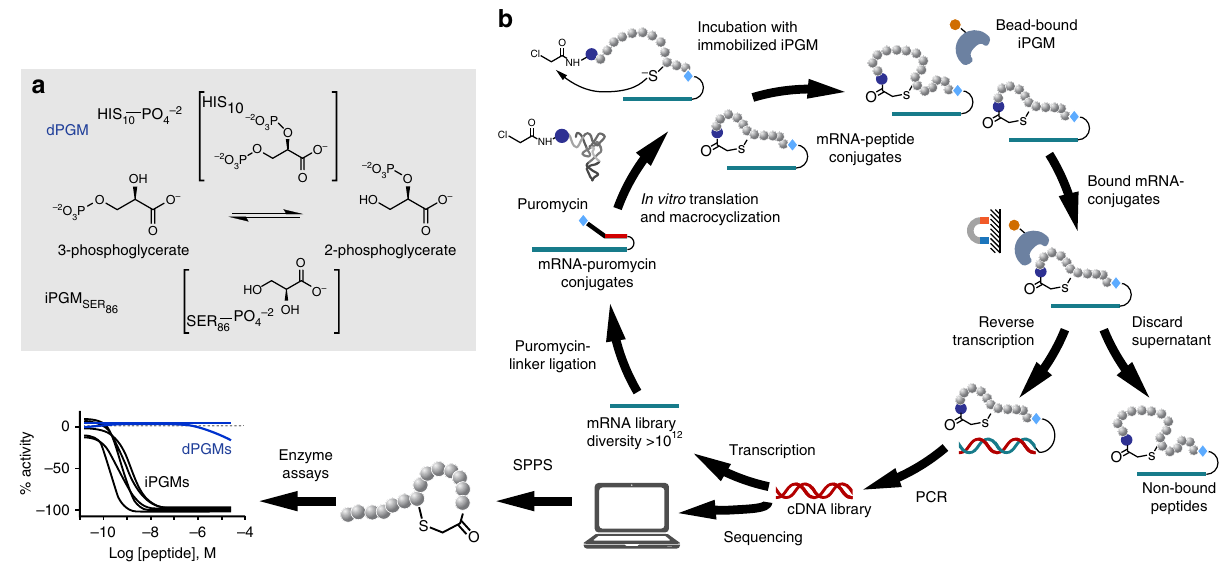
Figure 1 | Species-dependent phosphoglycerate mutase catalytic mechanisms and overview of affinity selection. ( a ) Isomerization catalysed by PGMs illustrating the phosphohistidine enzyme/2,3-phosphoglycerate intermediate of human cofactor-dependent PGM (top) and the phosphoserine enzyme intermediate of C. elegans cofactor-independent PGM. ( b ) Random nonstandard peptide integrated discovery (RaPID) begins with an mRNA library encoding trillions of potential peptides 6–14 amino acids in length. The mRNA library is ligated to an adapter incorporating the amino nucleoside, puromycin. The flexible in vitro translation (FIT) system is used to create the peptide library with an L - or D - N -chloroacetyl tyrosine (dark blue sphere) charged initiator tRNA and 19 proteogenic amino acids (grey spheres), methionine is excluded as its tRNA is charged with the chloroacetyl tyrosine. Incorporation of a cysteine during translation results in macrocyclization via thiolate nucleophilic attack on the chloroacetyl electrophile. After incubating with the library the beads are washed to enrich the bound conjugates which are then reverse transcribed and amplified via PCR. PCR products are transcribed to mRNAs and the process is repeated or PCR products sequenced to reveal the peptide sequences captured. Peptides from these sequences are then produced in milligram quantity using solid-phase peptide synthesis